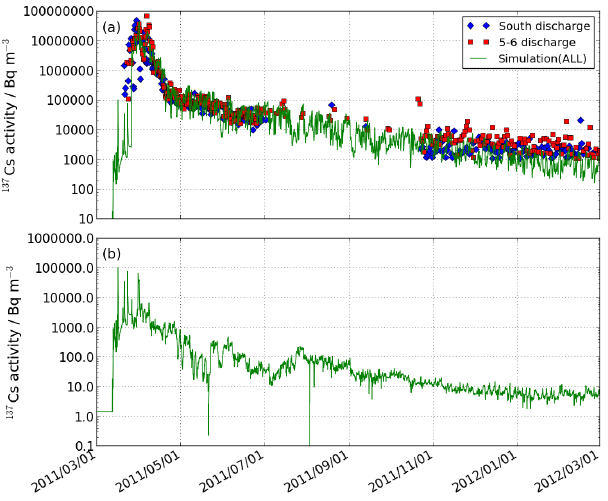
Fig. 5. (a) Measured 137 Cs activities (Bqm − 3 ) at the 5–6 (north) and south discharge canals near the 1F NPP and simulated 137 Cs ac- tivities in a grid adjacent to the 1F NPP site (ALL scenario). (b) Dif- ference of activities between the ALL and D RELEASE scenarios.